Question: What type of chart is this?
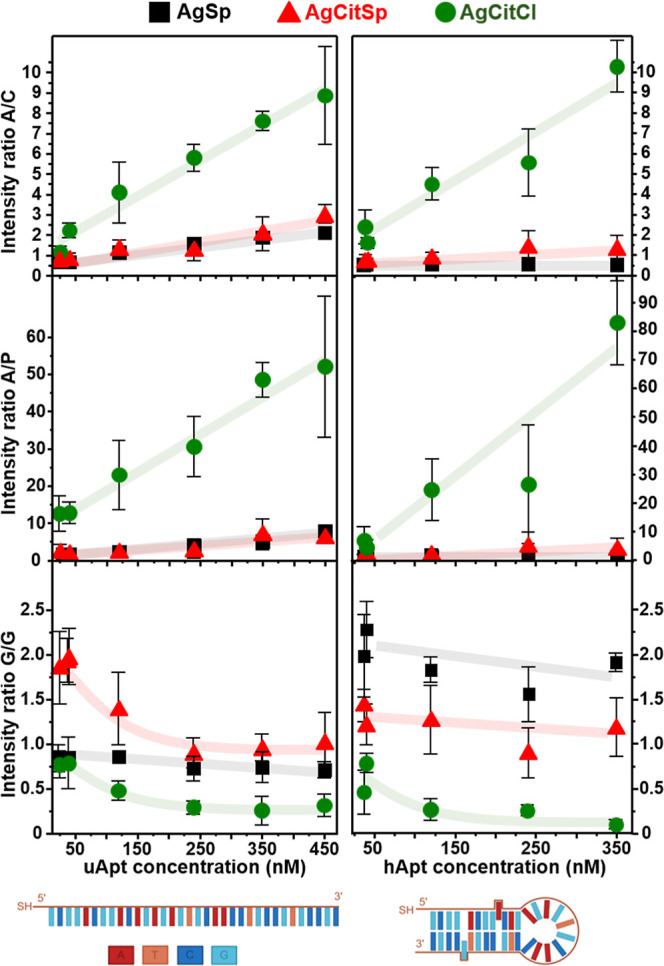
Answer: bar